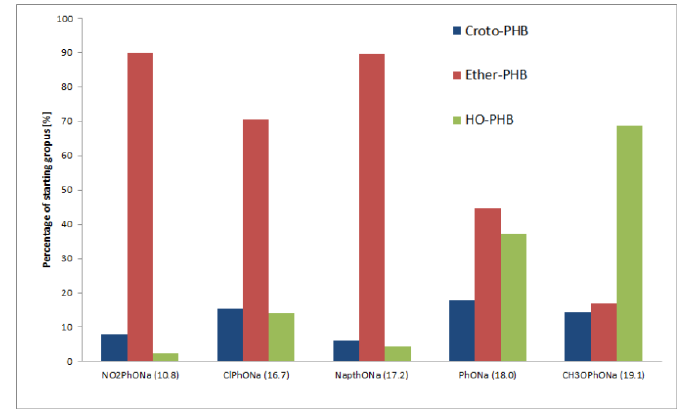
Figure 4. Ratio of crotonate, phenoxy and hydroxy initial groups in the polymer depending on the initiator used (estimated from 1 H NMR measurements; pKa values presented in parenthesis correspond to phenols used [38]).